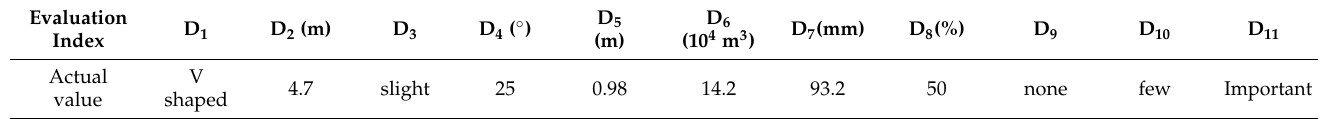
Table 4. Actual value of the evaluation